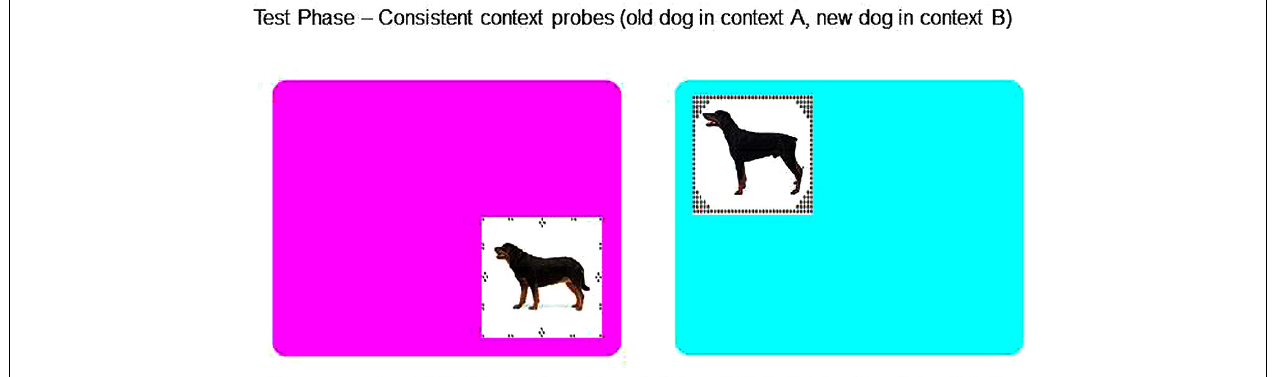
Frontiers in Psychology | Cognitive